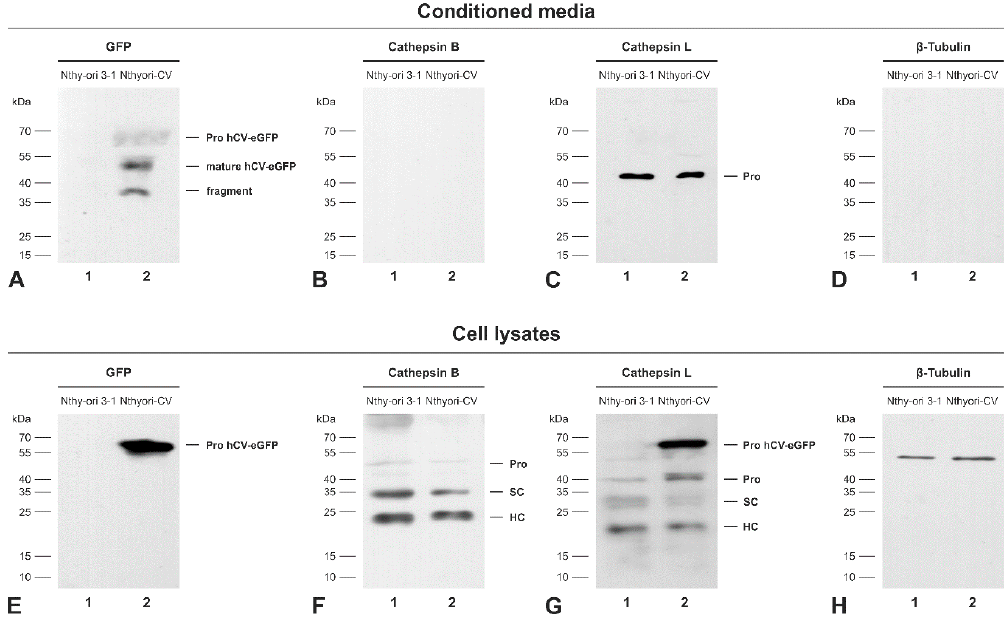
Figure 6. Secretion of hCV-eGFP chimeric protein from thyroid epithelial cells. TCA